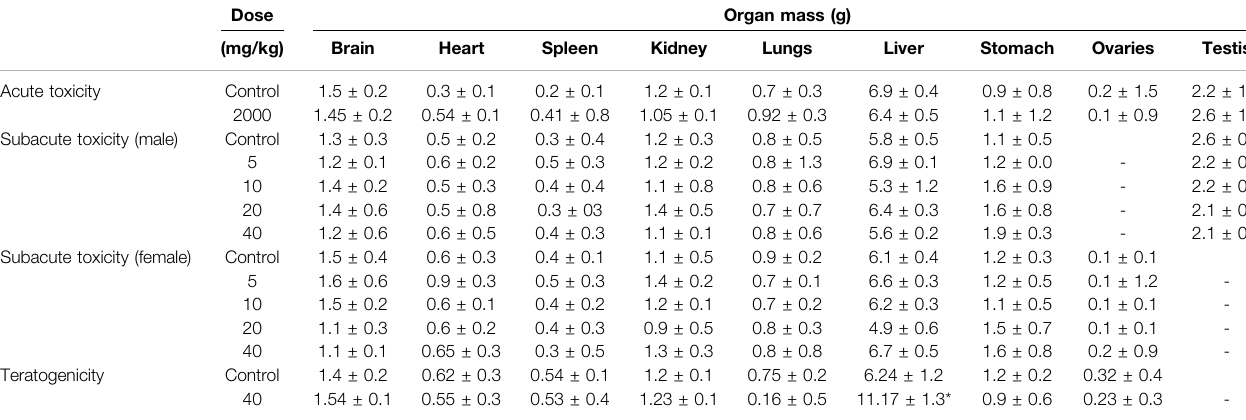
TABLE 2 | Variations in organ weights of the control and treated animals during acute, subacute, and teratogenic studies. Dose Organ mass (g)